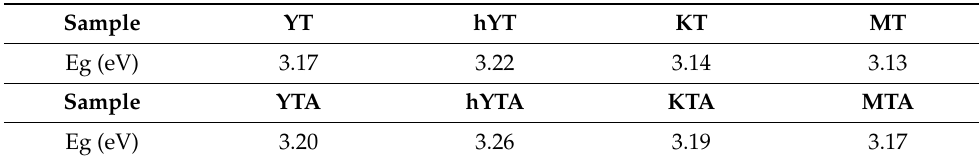
Table 2. Band gap energy of photocatalysts.